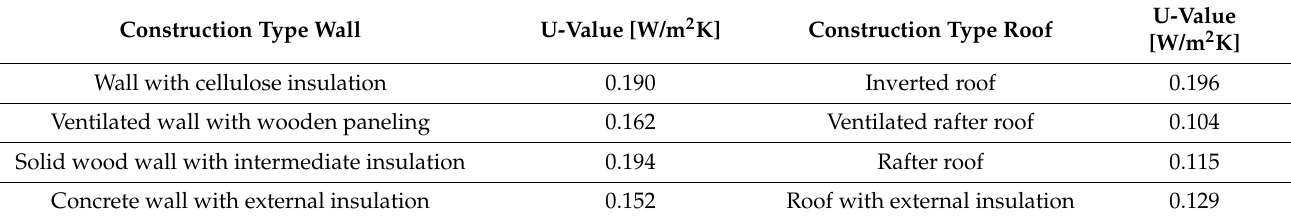
Table 2. Overview: Buildings extensions with different construction types [53].